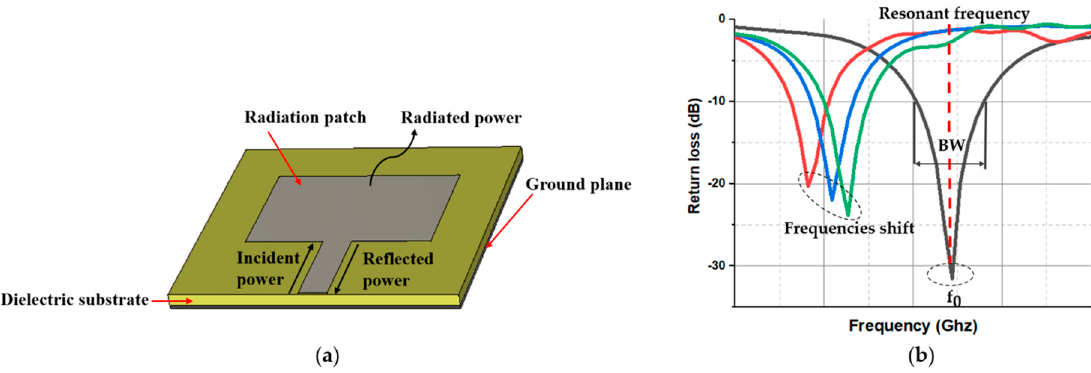
Figure 1. ( a ) Basic configuration of a microstrip antenna sensor and ( b ) illustration of frequencies shift of the antenna sensor.